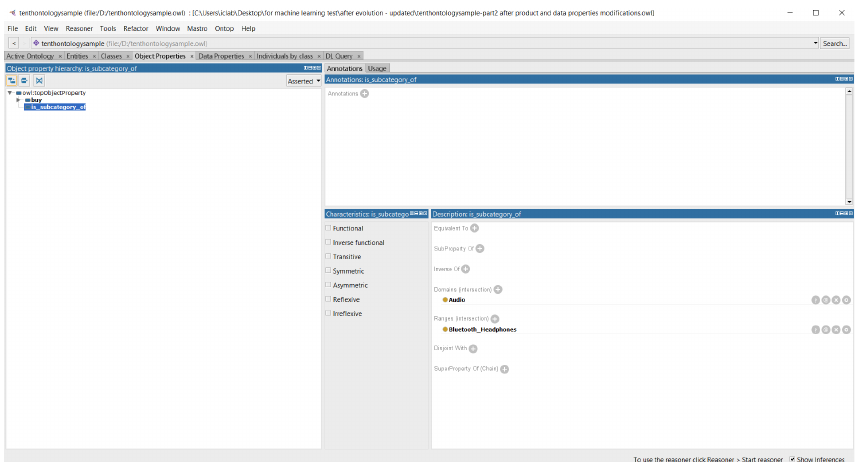
Figure 6. Online retail ontology object